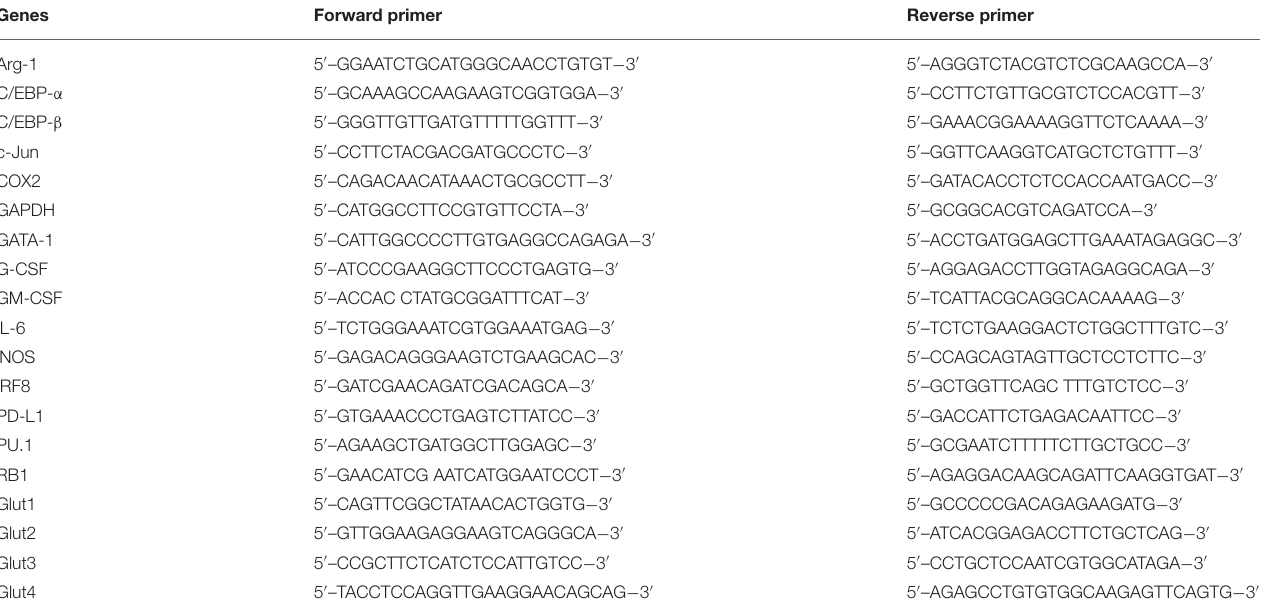
TABLE 1 | The qPCR primer list.